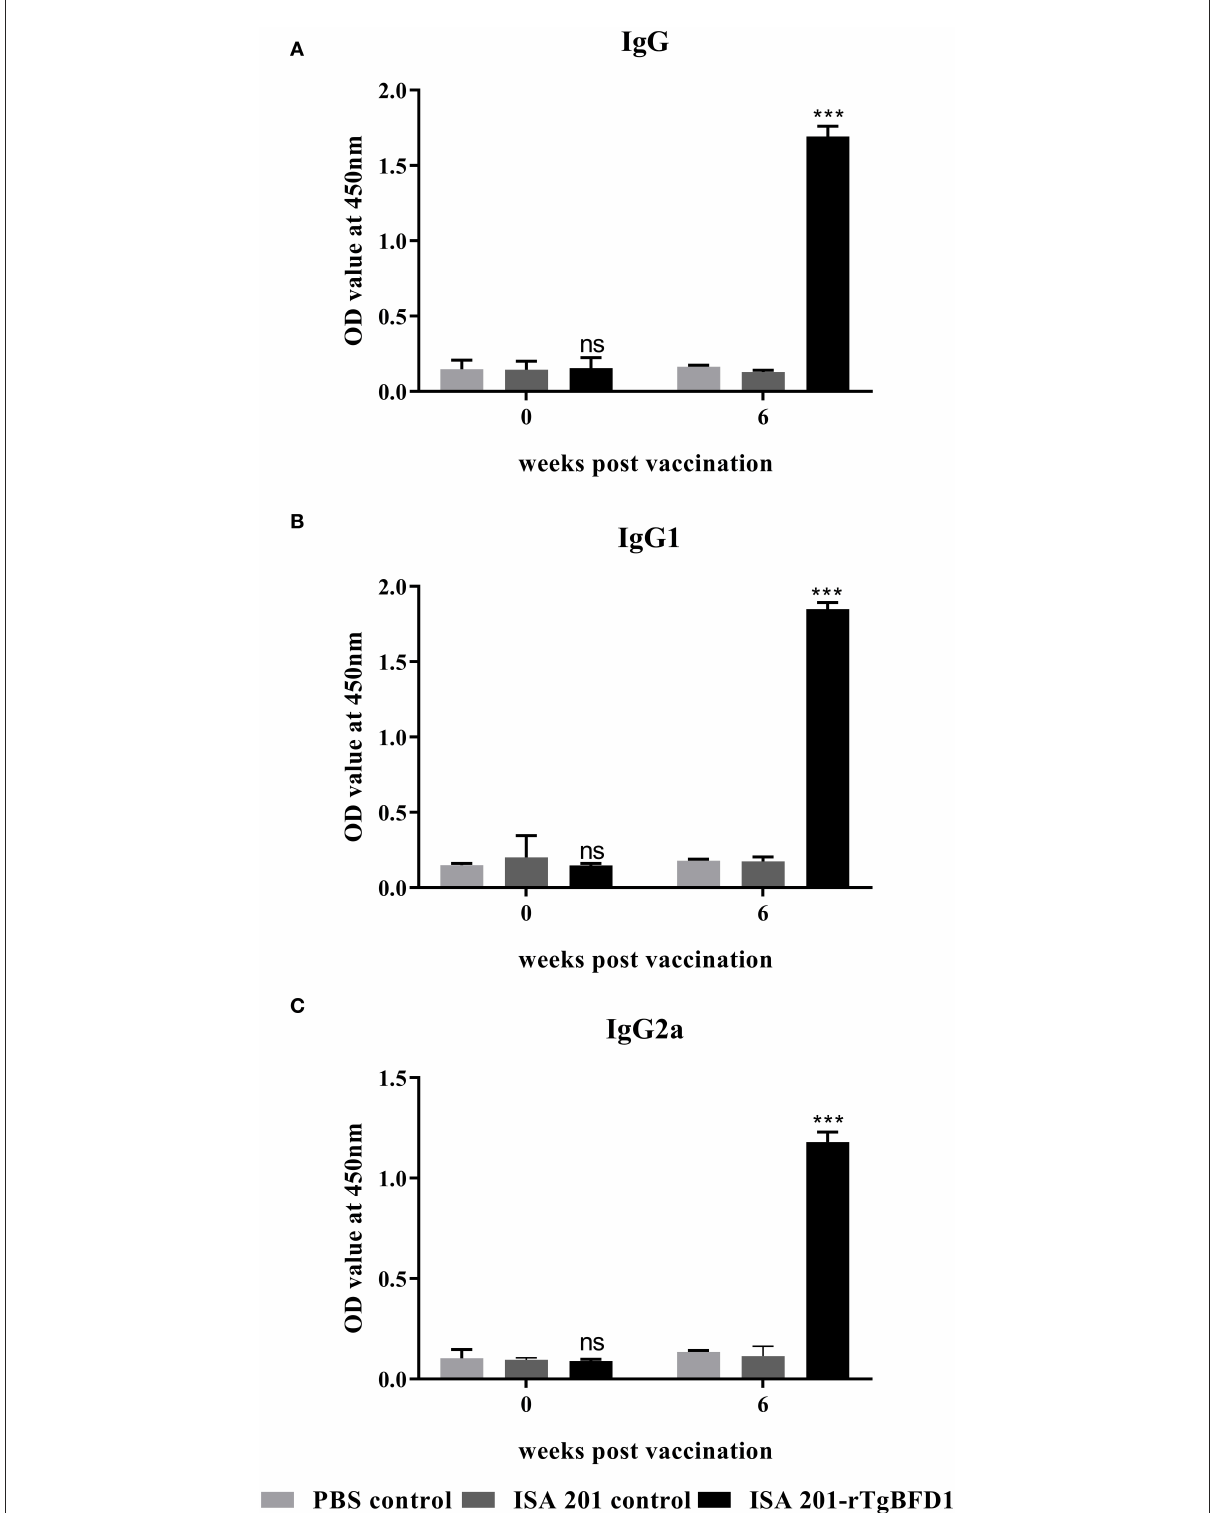
FIGURE4 Specific antibody responses analyses in mice inoculated with rTgBFD1. (A) Alterations in sera-specific IgG contents at 0 and 6 weeks after vaccination. (B) Alterations in sera-specific IgG1 contents at 0 and 6 weeks after vaccination. (C) Alterations in sera-specific IgG2a contents at 0 and 6 weeks after vaccination. Data were shown as mean ± SD from ten mice per group and analyzed by a one-way ANOVA. *** p < 0.001 and ns (non-significant) compared with the PBS control and the ISA 201 adjuvant